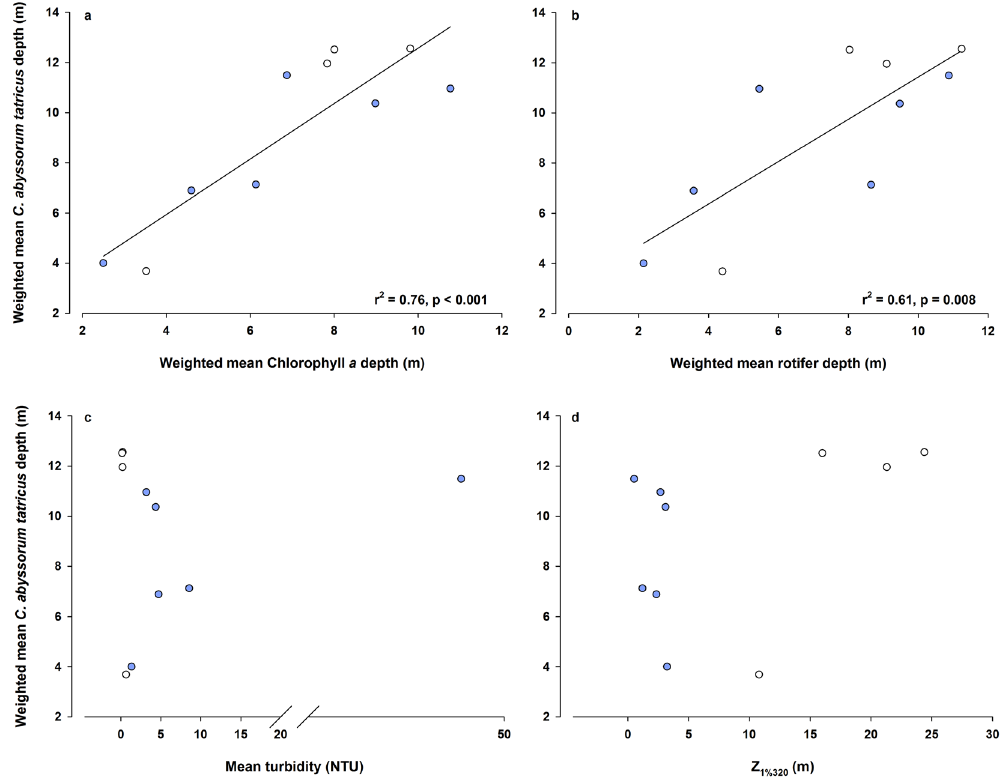
Figure 2. Weighted mean Cyclops abyssorum tatricus depth vs. ( a ) the weighted mean Chlorophyll a (Chl a ) depth, ( b ) weighted mean rotifer depth, ( c ) mean turbidity, and ( d ) 1% of the surface irradiance at 320 nm (Z 1%320 ). Open circles: clear lakes, closed circles: turbid lakes.